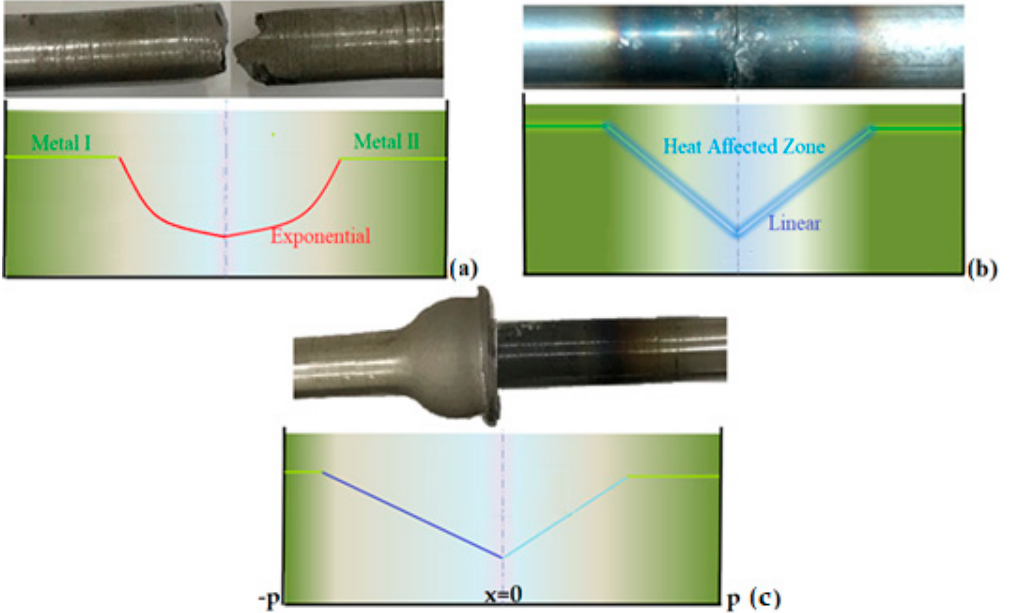
Figure 14. Functionally linear and exponential grading of the heat affected zone, ( a ) Arc welded